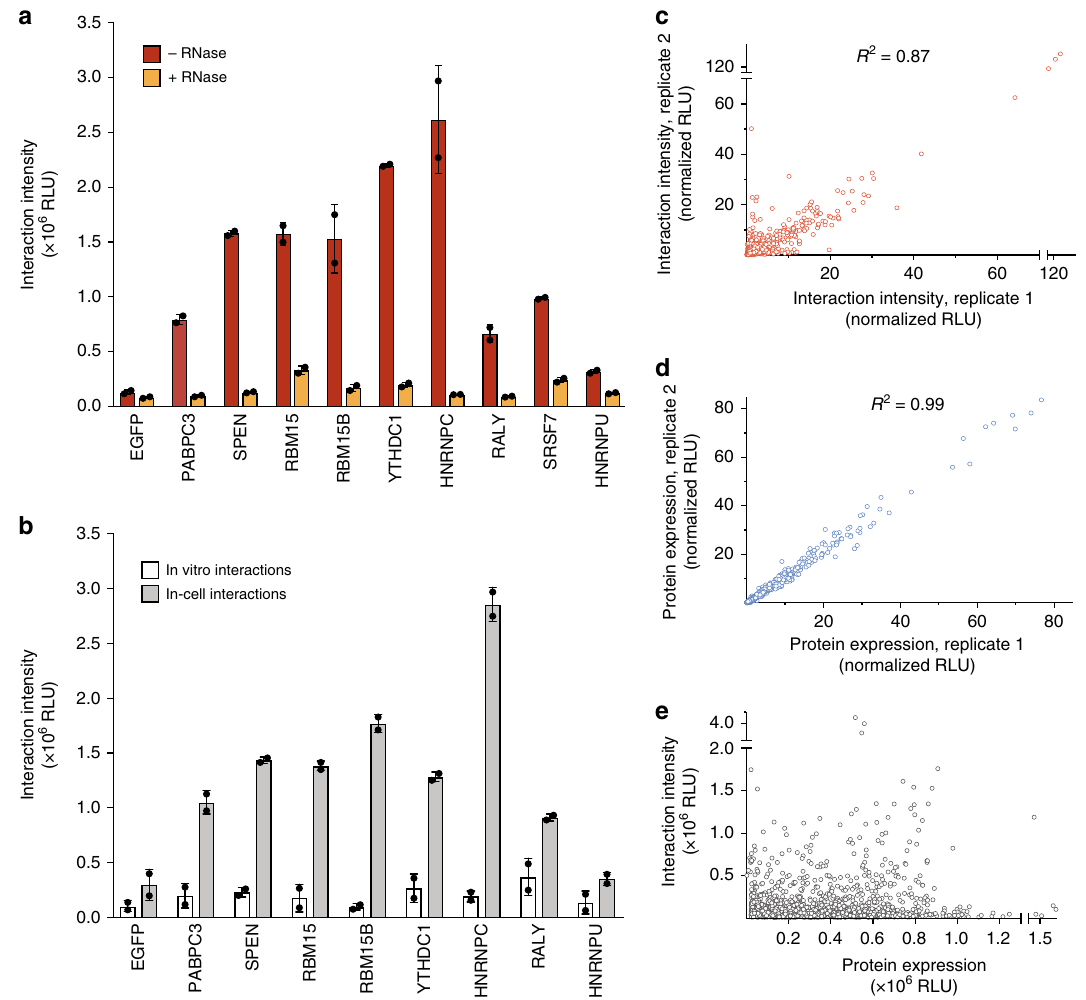
Fig. 2 incPRINT measures cellular RNA – protein interactions. a Interaction intensities detected between Xist(A)-MS2 and the indicated factors, with and without RNase treatment. Data from two biological replicates are presented as mean ± s.d.; RLU are relative light units. b Interaction intensities between Xist(A)-MS2 and the indicated factors. In-cell interaction values were measured in a standard incPRINT experiment. In vitro interaction values resulted from separate transfections of the tagged proteins and Xist(A)-MS2 RNA, which were combined for interaction analyses after the cells were lysed. Data from two biological replicates for each experiment are presented as mean ± s.d.; RLU are relative light units. c Scatter plot showing the correlation of the Xist(A)- MS2 interaction intensities determined by NanoLuc luciferase luminescence from two biological replicates. Shown are median-normalized values. Squared Pearson correlation coef fi cient is indicated. d Scatter plot showing the correlation of FLAG-tagged protein expression levels determined by anti-FLAG ELISA from two biological replicates. Shown are median-normalized values. Squared Pearson correlation coef fi cient is indicated. e Scatter plot showing RNA – protein interaction intensities and protein expression levels. RLU are relative light